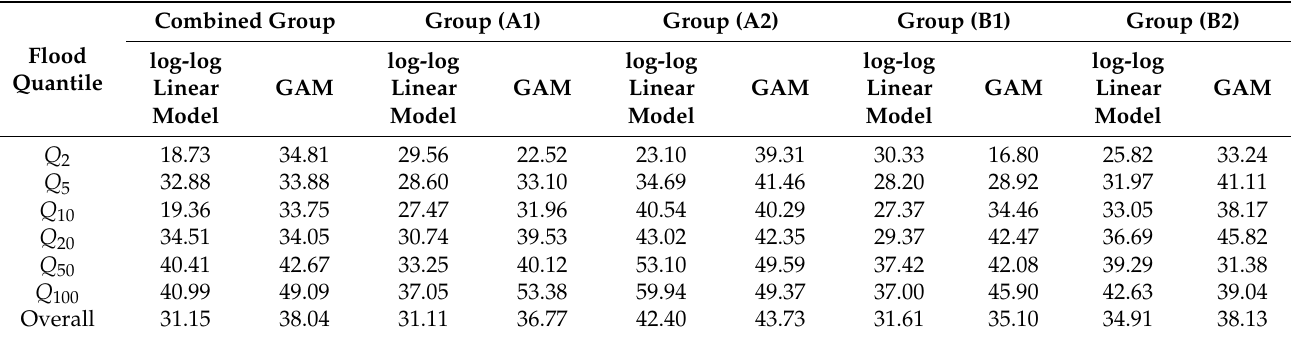
Table 5. Median RE values (%) for the GAM and log-log linear model based RFFA techniques for ten